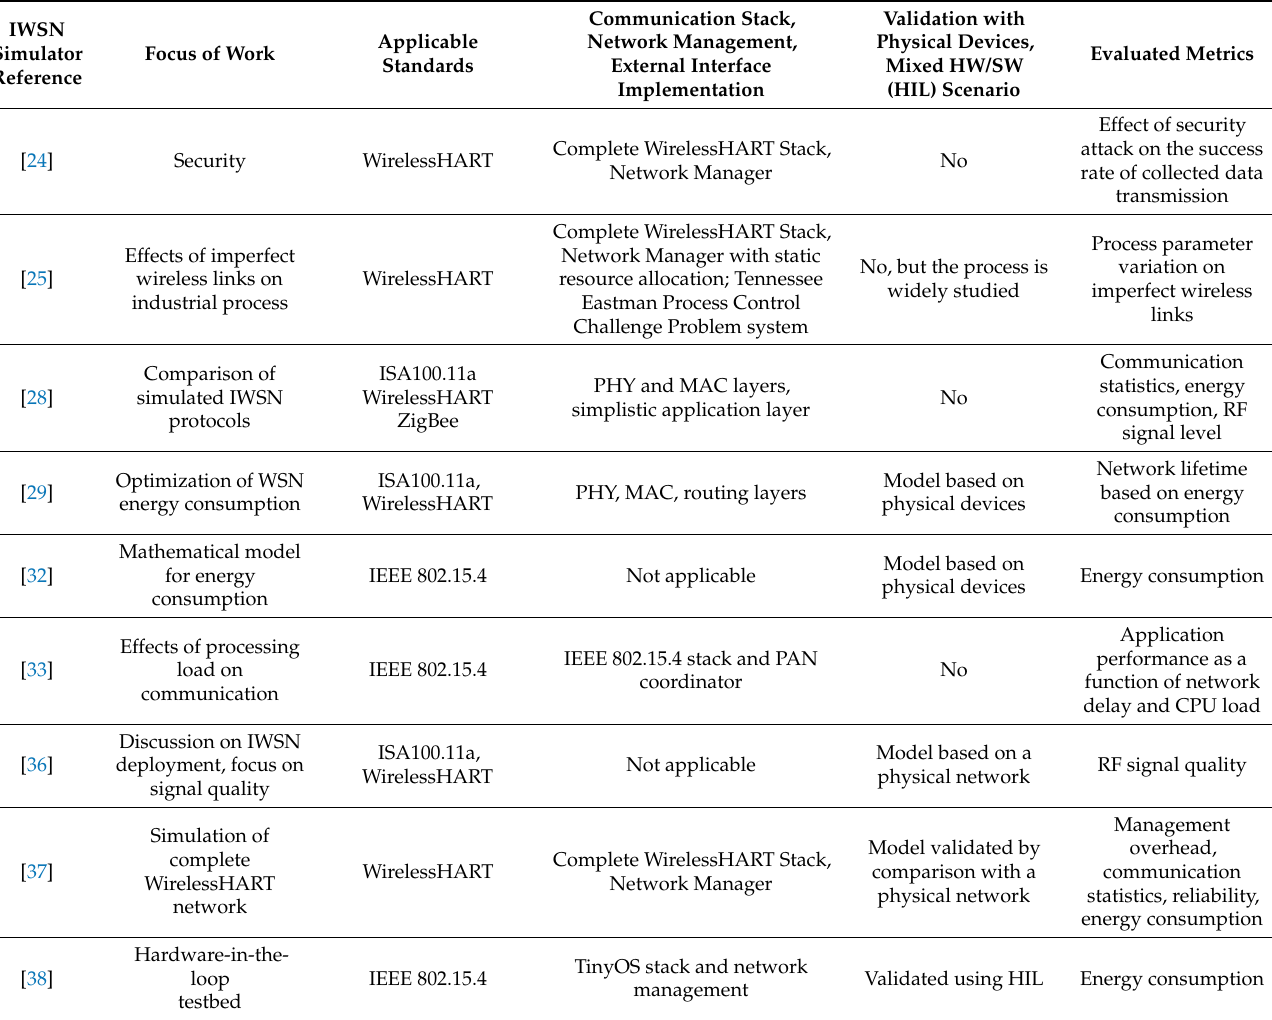
Table 1. Features of IWSN simulation